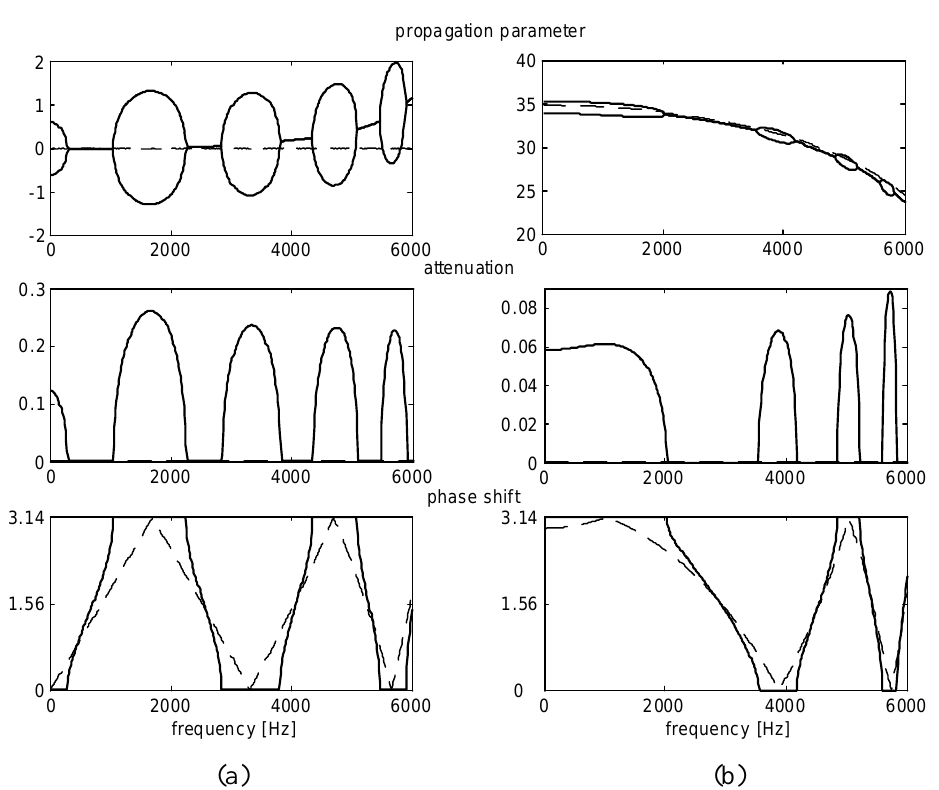
Fig. 7. Propagation constants of uniform (dash) and exponential FGM (solid) shells: (a) longitudinal direction, (b) radial direction.